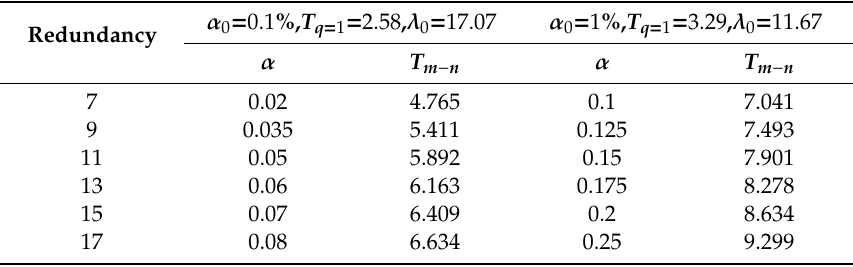
Table 3. Variation of the global test parameter α against α 0 and the redundancy using the chi-square test.